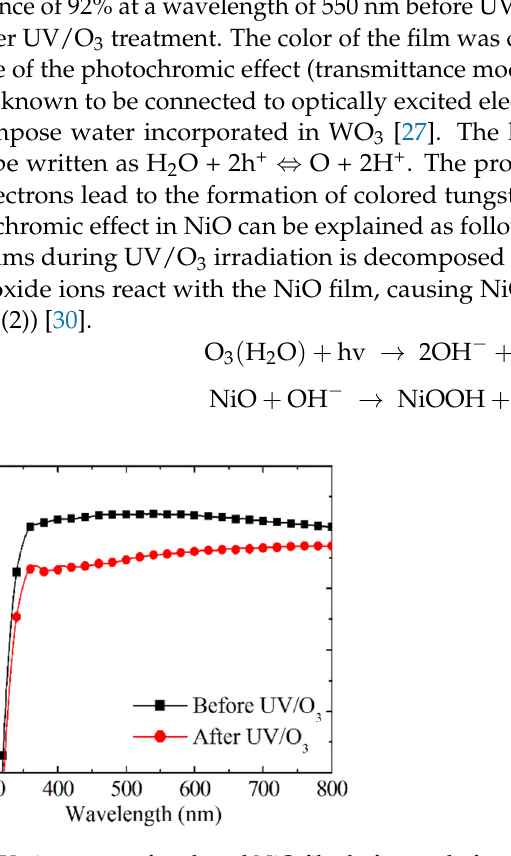
Figure 4. UV-vis spectra of undoped NiO film before and after 70 min UV/O 3